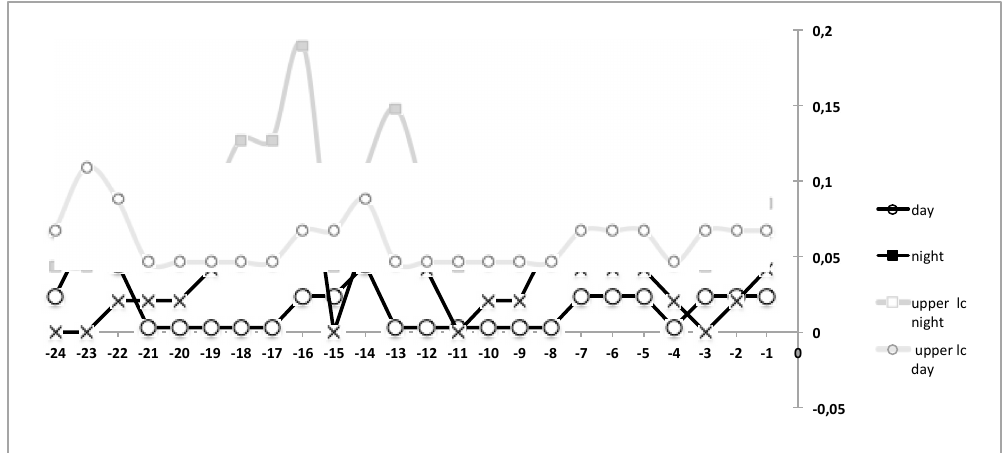
Figure 2. Least square means (LSM) and 95% upper confidence limits (cl) of walking for cows that calved at night and by day. On the x-axis: hour relative to delivery; on the y-axis: hourly proportion of records ( n /12).